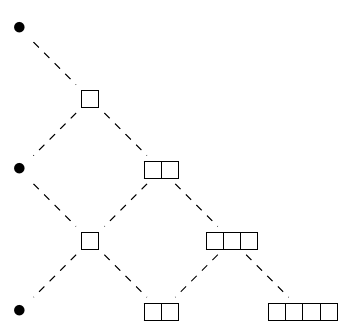
Figure 1. Inverse Higgs tree for a single essential scalar in a Lorentz invariant theory, from